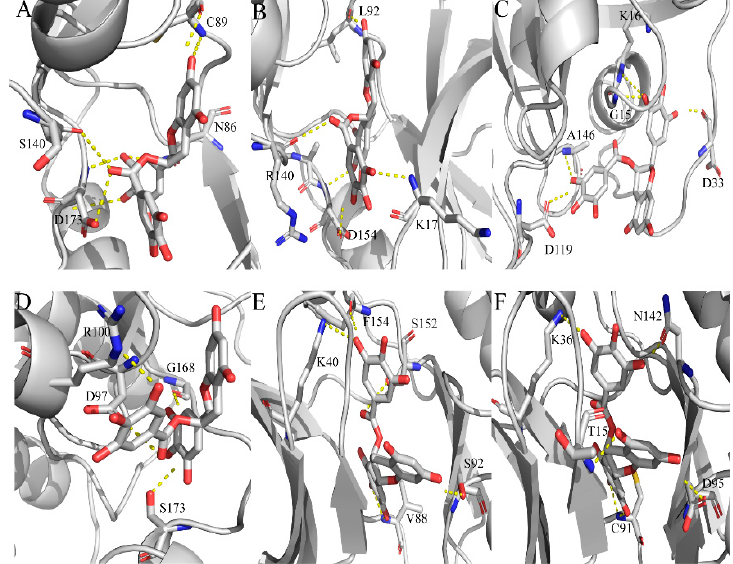
Figure 7. Analysis of binding modes between EGCG and potential target proteins. ( A ) Binding mode of mitosis inhibitor protein kinase WEE1 (PDB ID: 1X8B). ( B ) Binding mode of tyrosine-protein kinase JAK3 (PDB ID: 1YVJ). ( C ) Binding mode of kirsten rat sarcoma viral oncogene (KRAS, PDB ID: 3GFT).